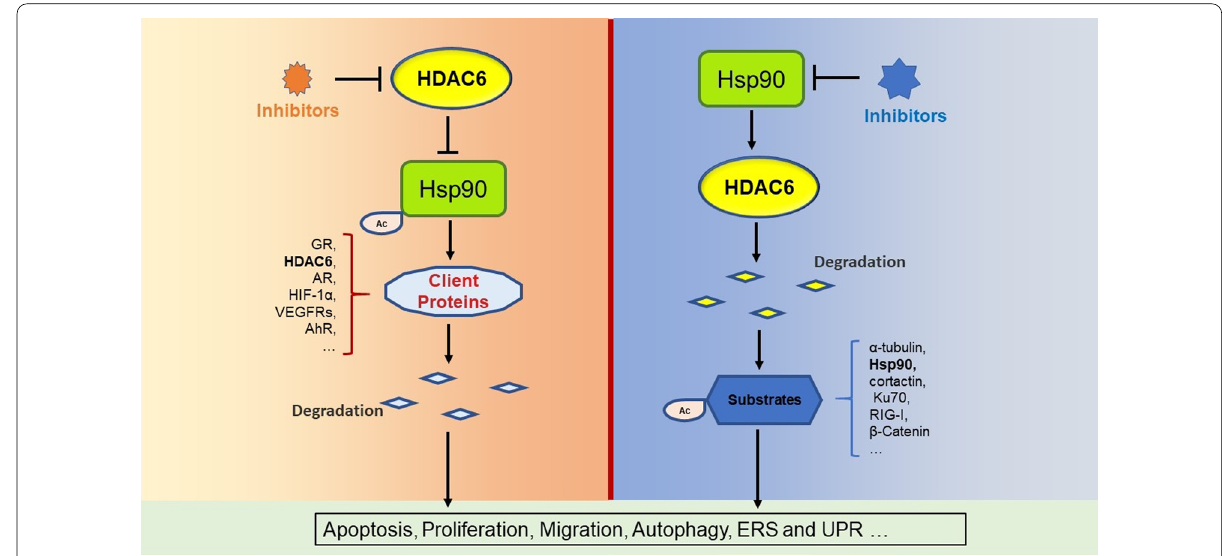
Fig. 2 Interplay between HDAC6 and